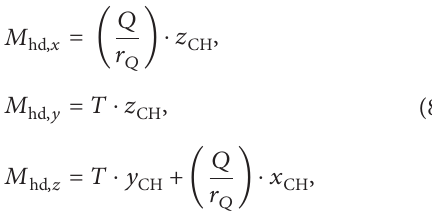
radius of blade carrier, thickness of blade bearing, and Young’s modulus of elasticity. Here, the value of friction coefficient ( 𝜇 ) is about 0.1 and 𝛼 is approximately 170 [deg.] and they are chosen for present